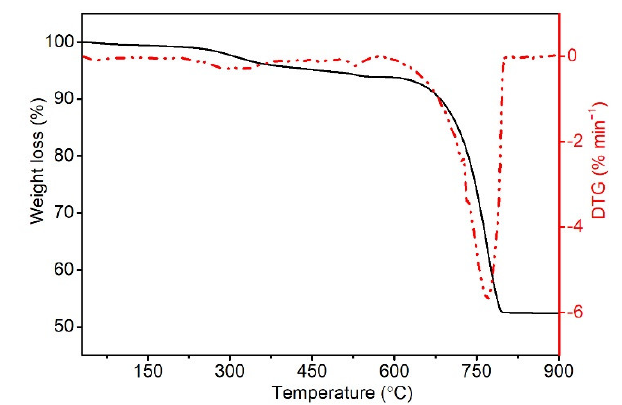
Figure 2. TG thermogram of ES filler in nitrogen.